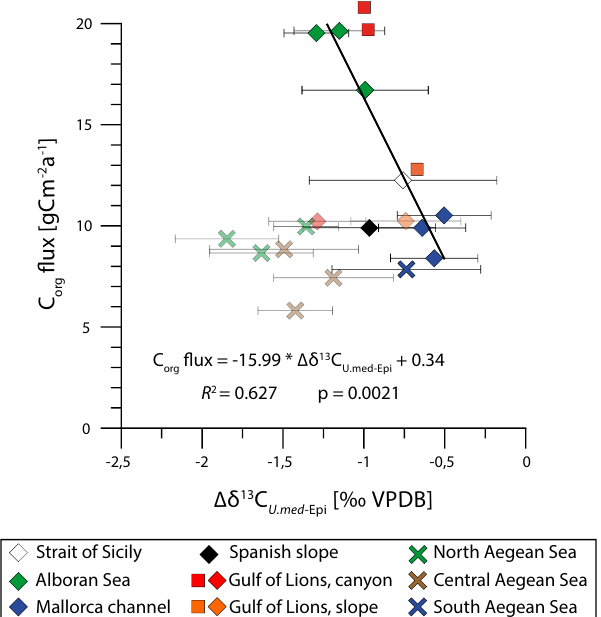
Figure 6. Correlation of the δ 13 C difference between live Uvige- rina mediterranea and epifaunal taxa ( (cid:49)δ 13 C Umed-Epi ) and organic carbon flux rate (C org flux) calculated according to Antoine and Morel (1996) and Betzer et al. (1984). Transparent data from the central and northern Aegean Sea and the Gulf of Lion have been re- moved from the function since PP-based C org flux values are likely underestimated because of the additional influence of lateral organic matter fluxes on the δ 13 C Umed values in these